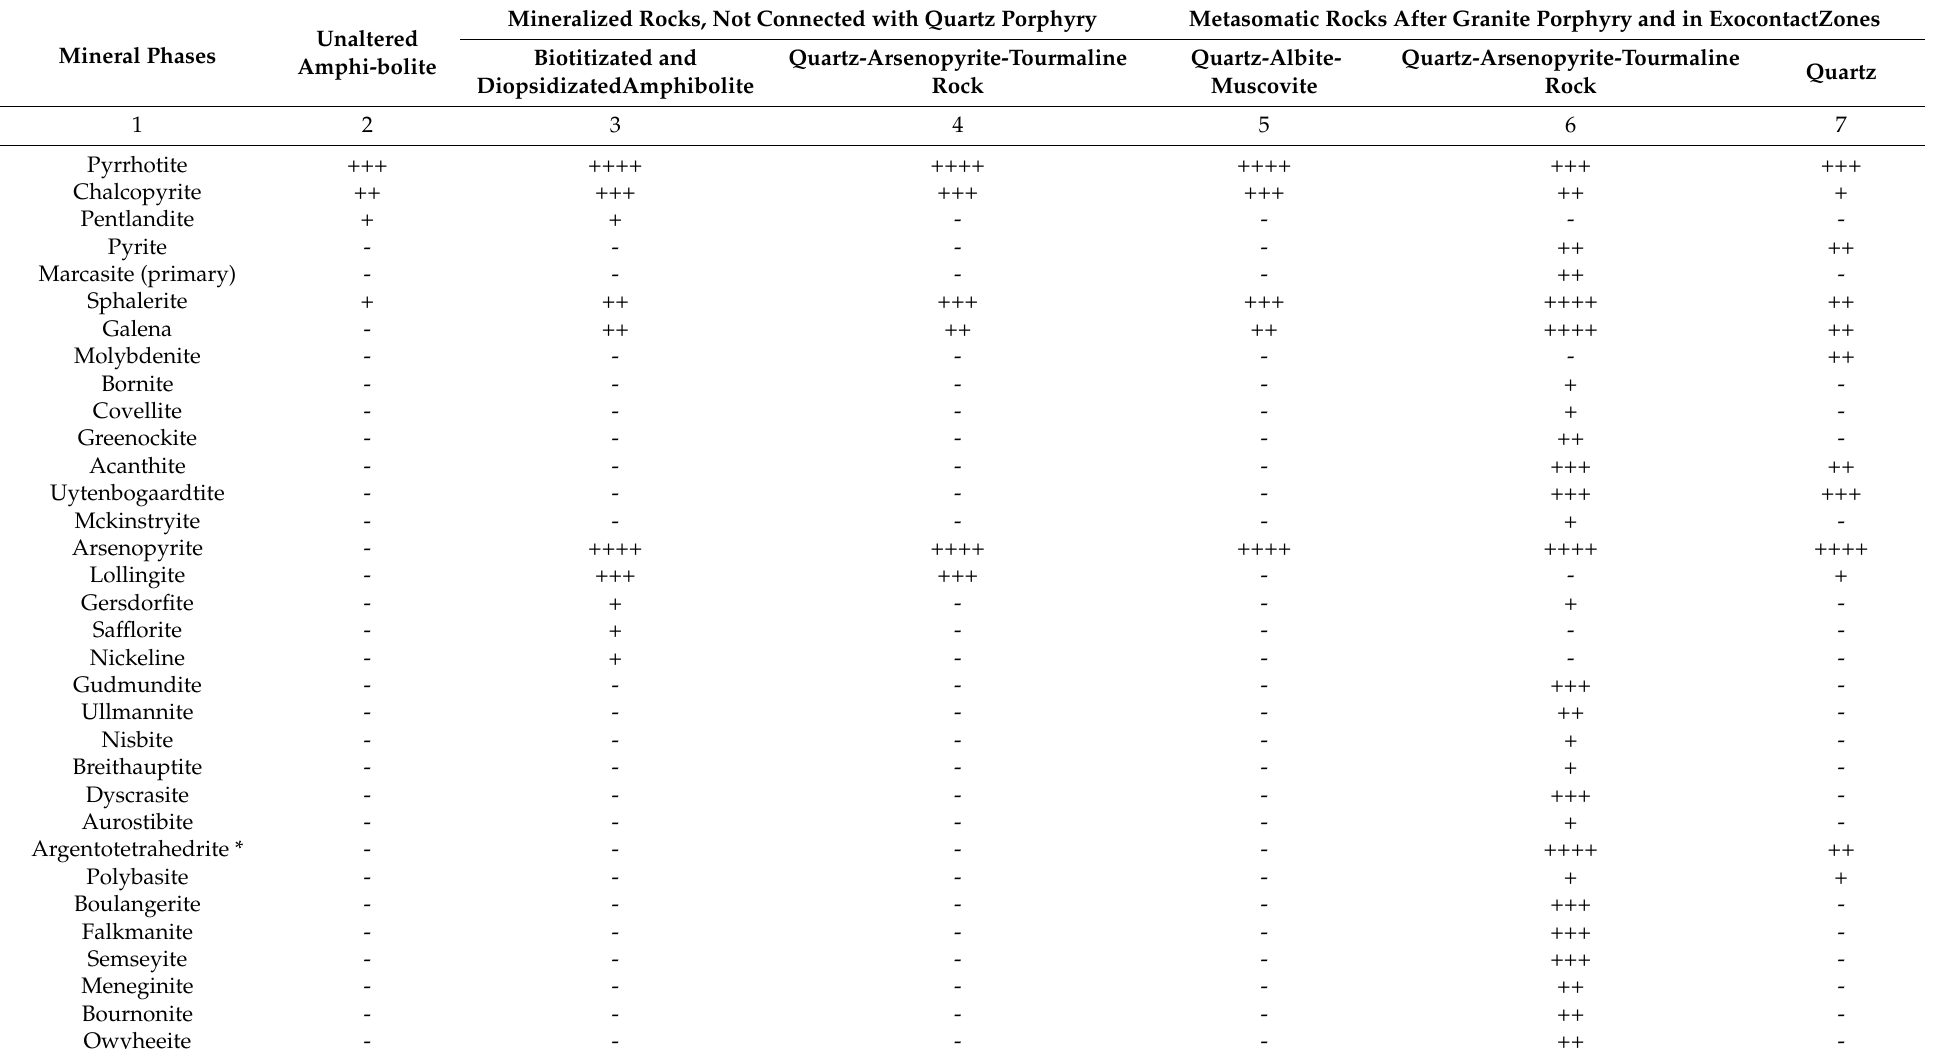
Table 6. Ore minerals (native metals, sulfides, and their analogues) in the rocks of the Oleninskoe